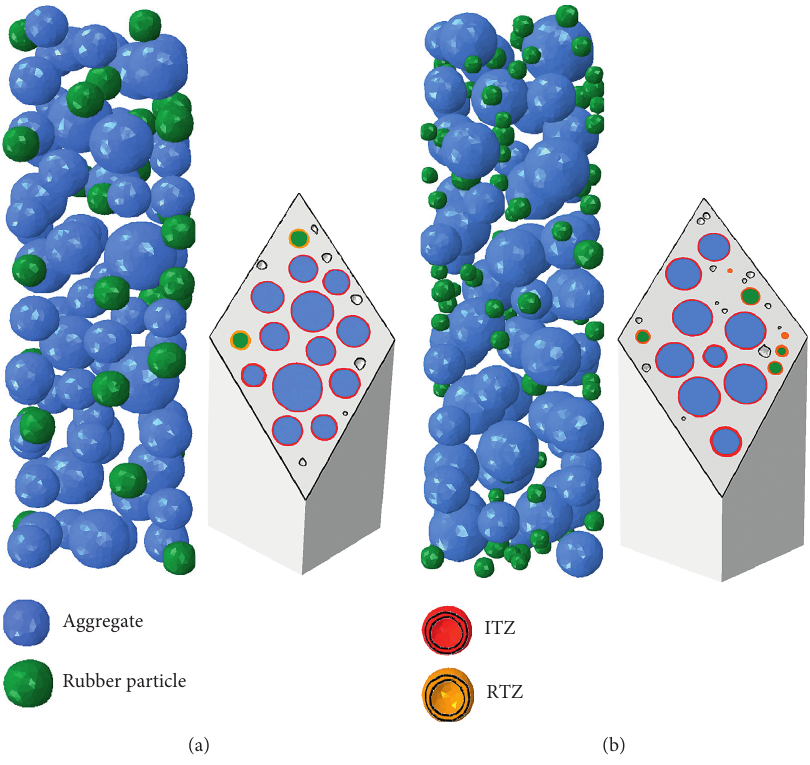
0.00.51.01.52.02.53.0 curve0.00.51.01.52.02.5 Mean strength: 2.911MPa Strength standard deviation: 0.03MPa